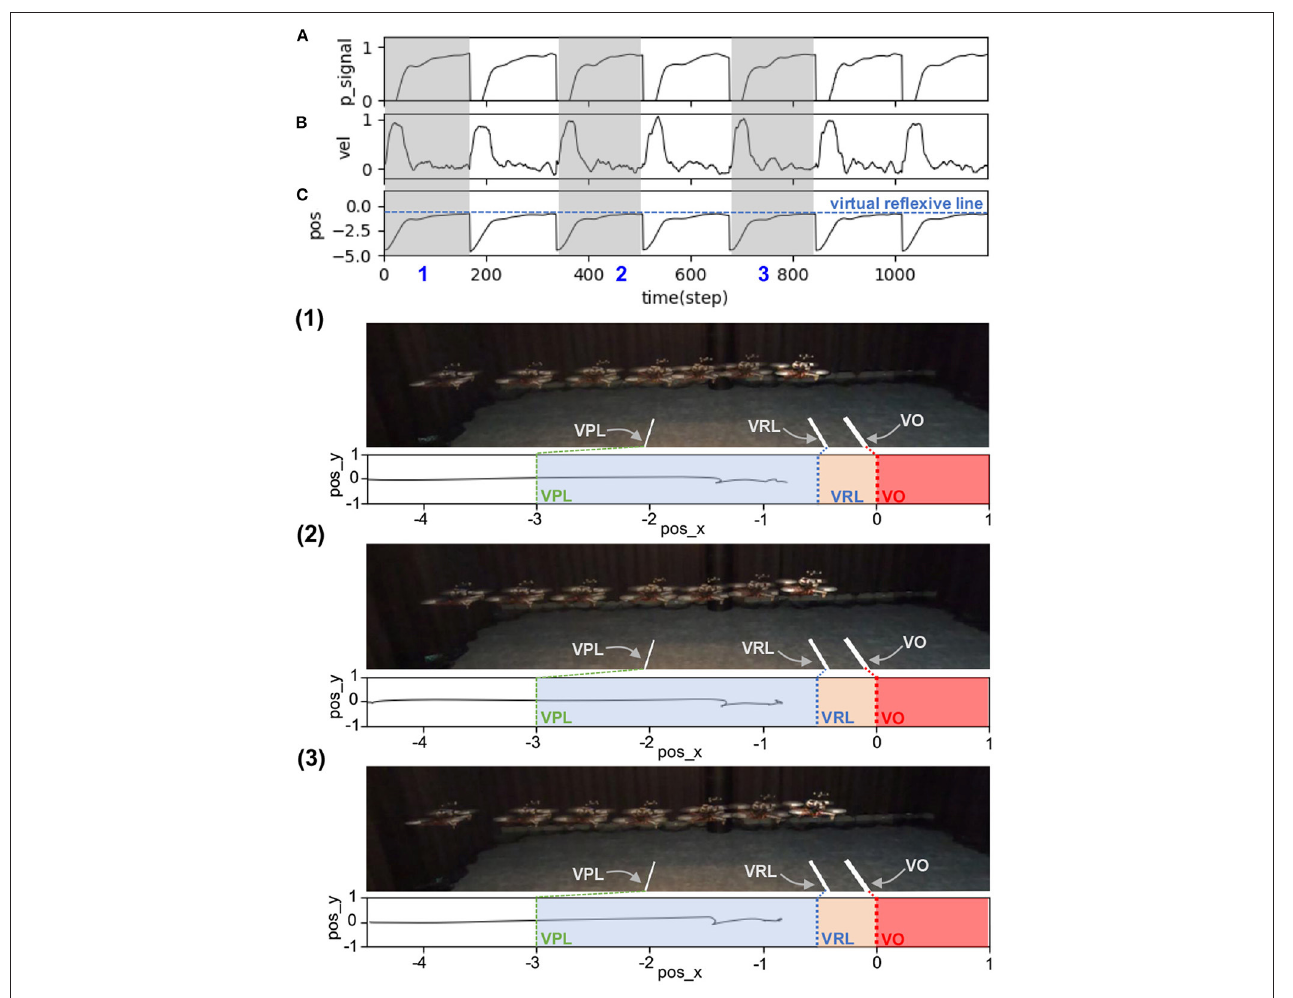
FIGURE 8 | Real-time data when flying the UAV at a maximum speed of 0.75 m/s and using an approximated predictive weight of 1.03 (obtained from Figure 7 ) as the initial weight. Each graph shows: (A) predictive signal, (B) actual speed (x-axis) of the UAV, and (C) position on the x-axis of the UAV compared to the virtual reflexive line (blue line). The gray areas represent three periods, showing the position of the UAV with respect to the virtual predictive line (VPL), virtual reflexive line (VRL), and virtual obstacle (VO) in three snapshots together with the corresponding estimated trajectories (1, 2,